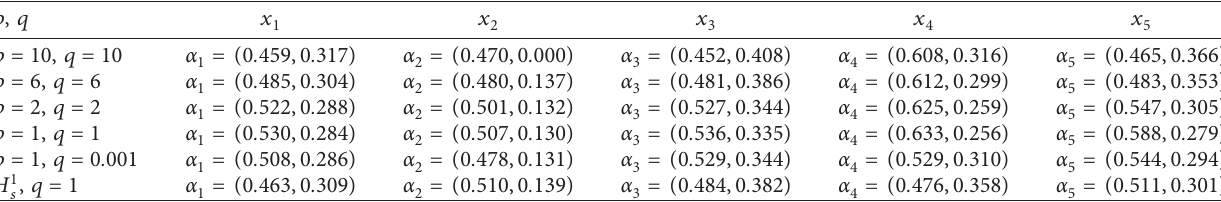
Table 2: The comprehensive evaluation value by IFNWOGBM.